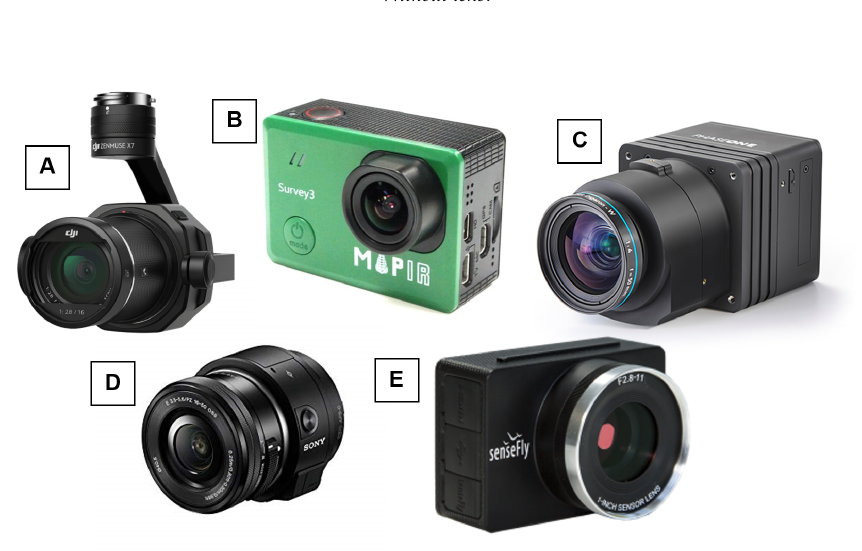
Figure 5. Some commonly used UAS Visual-Band cameras, listed in Table 3: ( A ) DJI Zenmuse X7; ( B ) MAPIR Survey3 (also avaliable in multispectral option); ( C ) PhaseOne iXU-RS 1000; ( D ) Sony ILCE-QX1; ( E ) senseFly